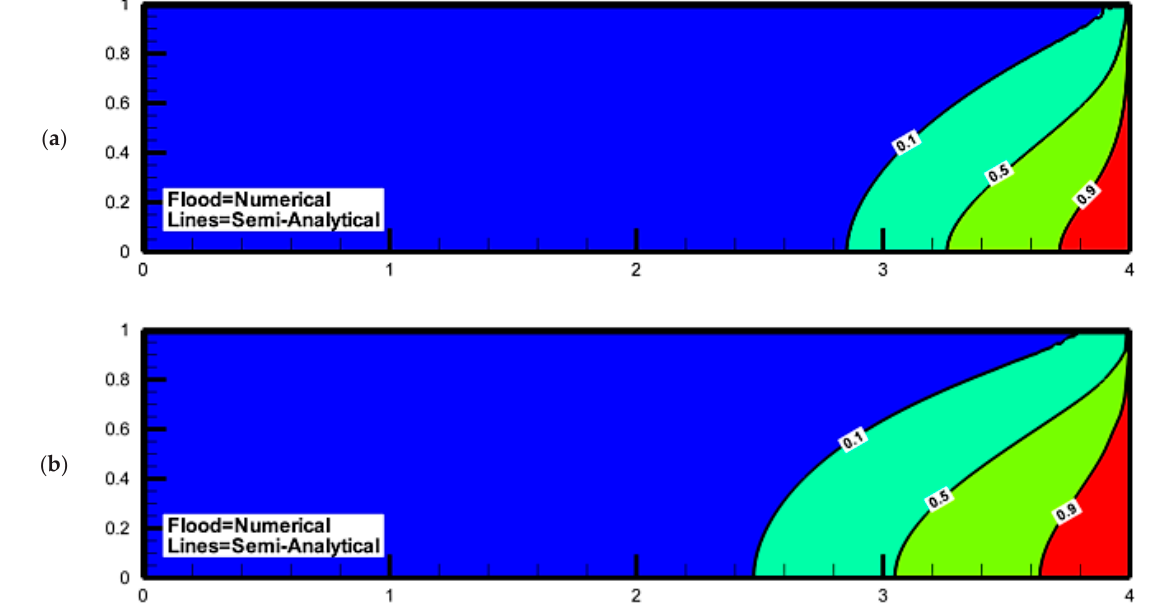
Figure 4. Semi-analytical and numerical isochlors (10%, 50% and 90%) for the pure diffusive cases: ( a ) homogenous and ( b ) heterogonous aquifer. Table 3. Physical parameters used in the numerical model for the verification test cases ( L toe : length of the toe, W MZ : average vertical width of the mixing zone, Q S : total dimensionless salt flux, d disch : depth of the zone of groundwater discharge to the sea).